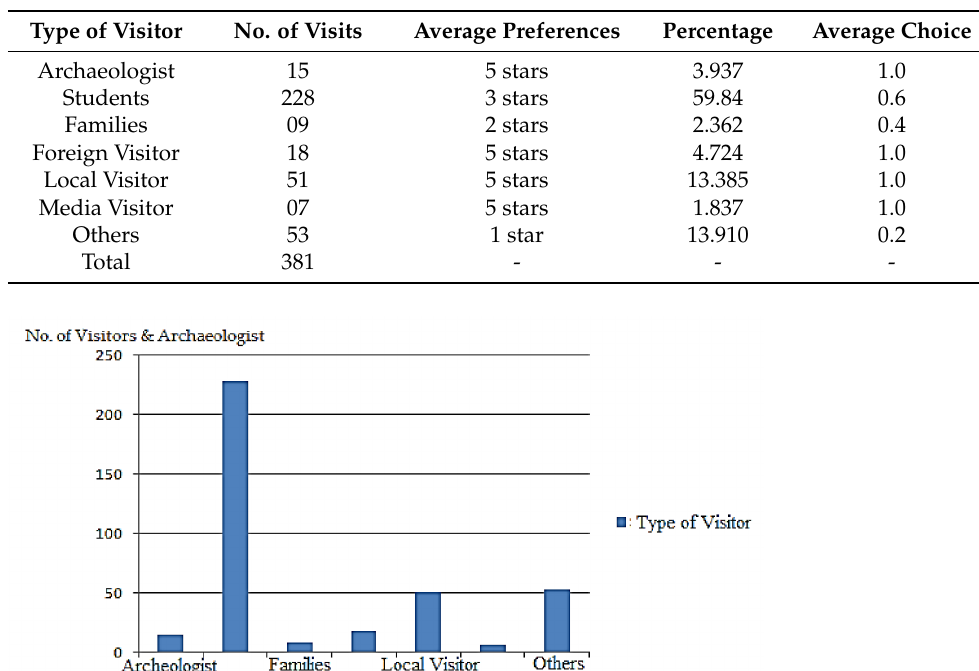
Table 4. Types of visitors and preference.